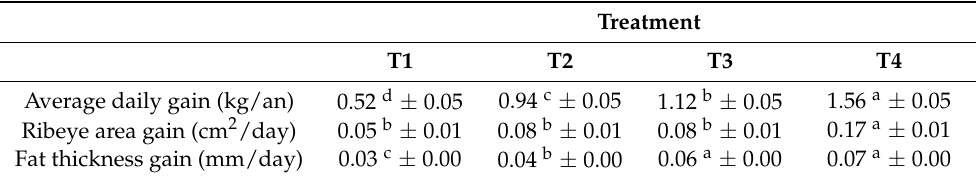
Table 1. Average daily gain, ribeye area gain, and fat thickness gain by treatment. Least square means ± standard error. Treatment T1 T2 T3 T4 0.52 d ±